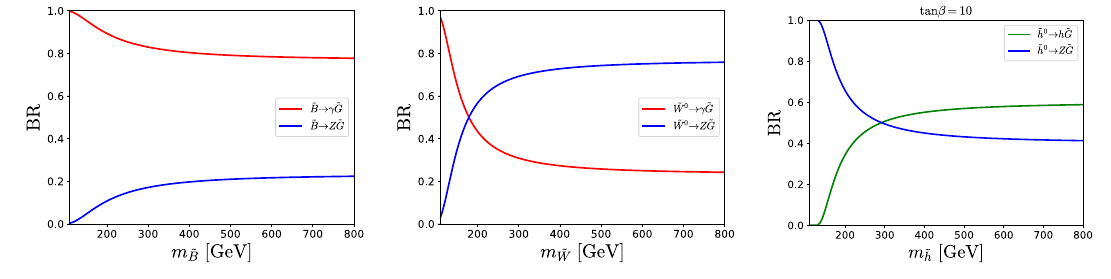
Figure 2 . Branching ratios to